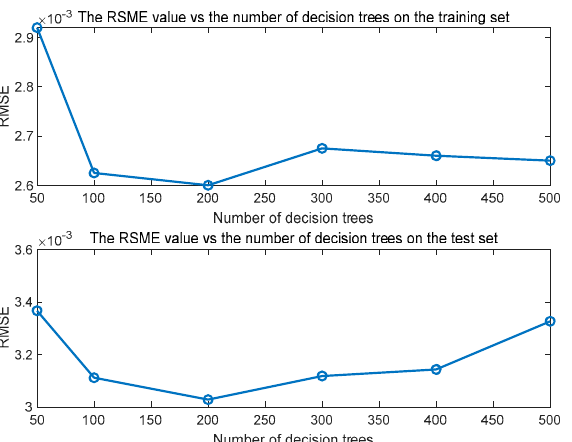
Figure 7. The relationship between the RSME of prediction error and the number of decision trees.